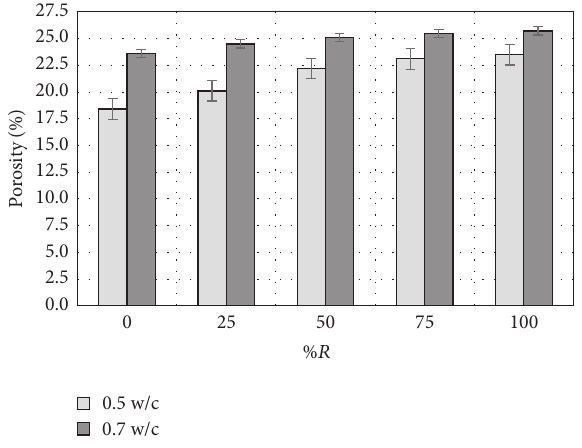
Figure 1: Porosity versus % 𝑅